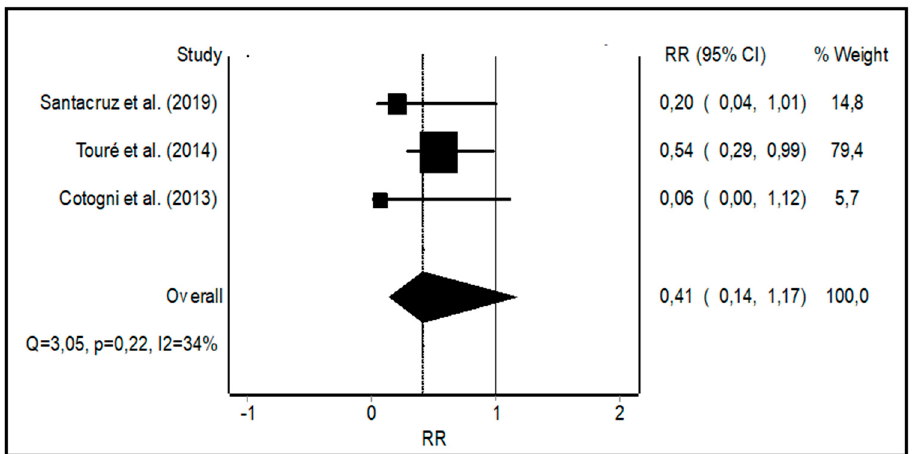
Figure 2. Forest plot showing the relative risk (RR) of catheter-related bloodstream infection (CRBSI) with peripherally inserted central catheters (PICCs) vs. tunneled central catheters. I 2 , a measure of heterogeneity.